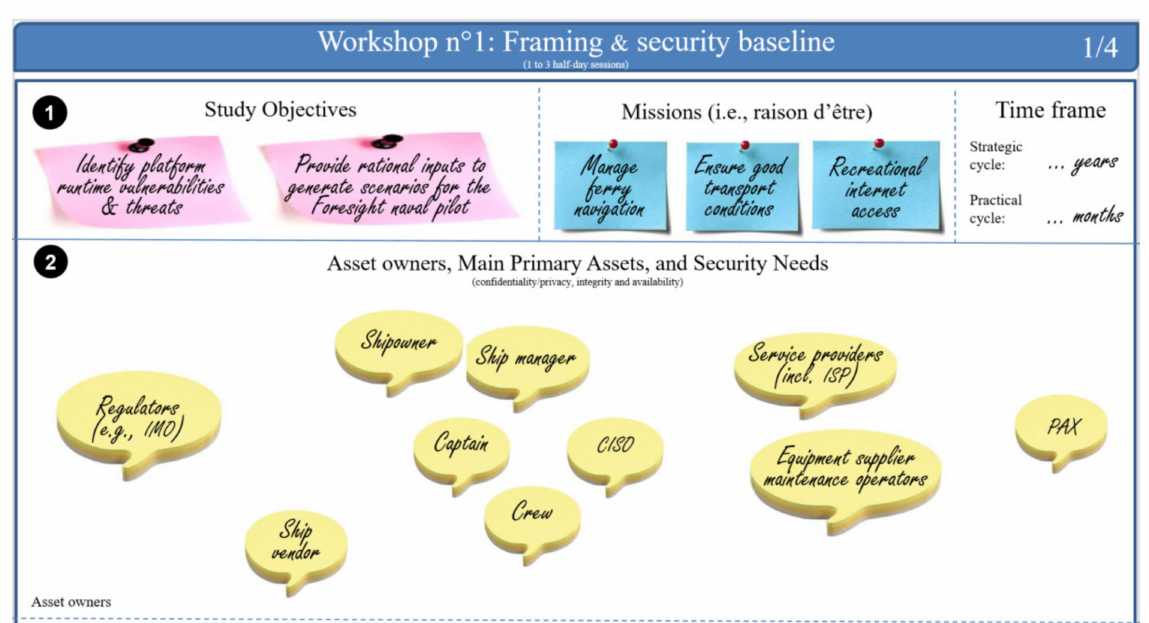
Figure 2. Naval use case—study objectives, system missions and key asset